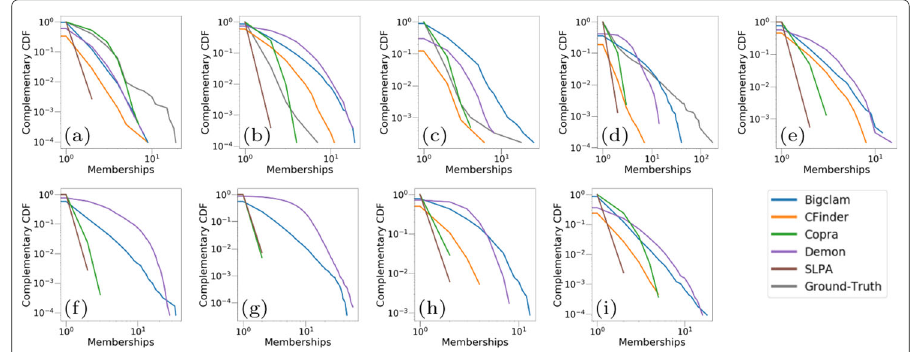
Fig. 28 Memberships of the nodes identified by the methods considering the real-world networks: a Amazon; b DBLP; c LiveJournal; d Youtube; e CAGrQc; f CAHepPh; g CitHepTh; h Email; i